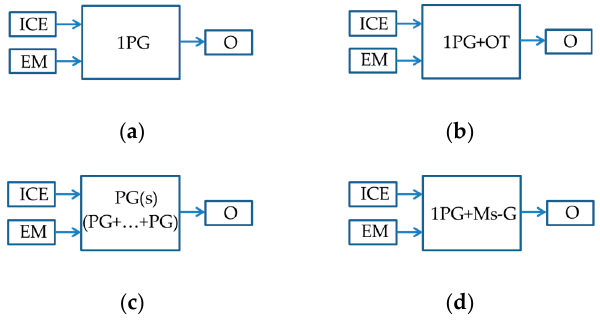
Figure 9. Four configurations of single EM (SEM)-PHPS: ( a ) type-a; ( b ) type-b; ( c ) type-c; ( d ) type-d. (OT—other transmission; Ms-G—multi-axis gearbox; O—output.).